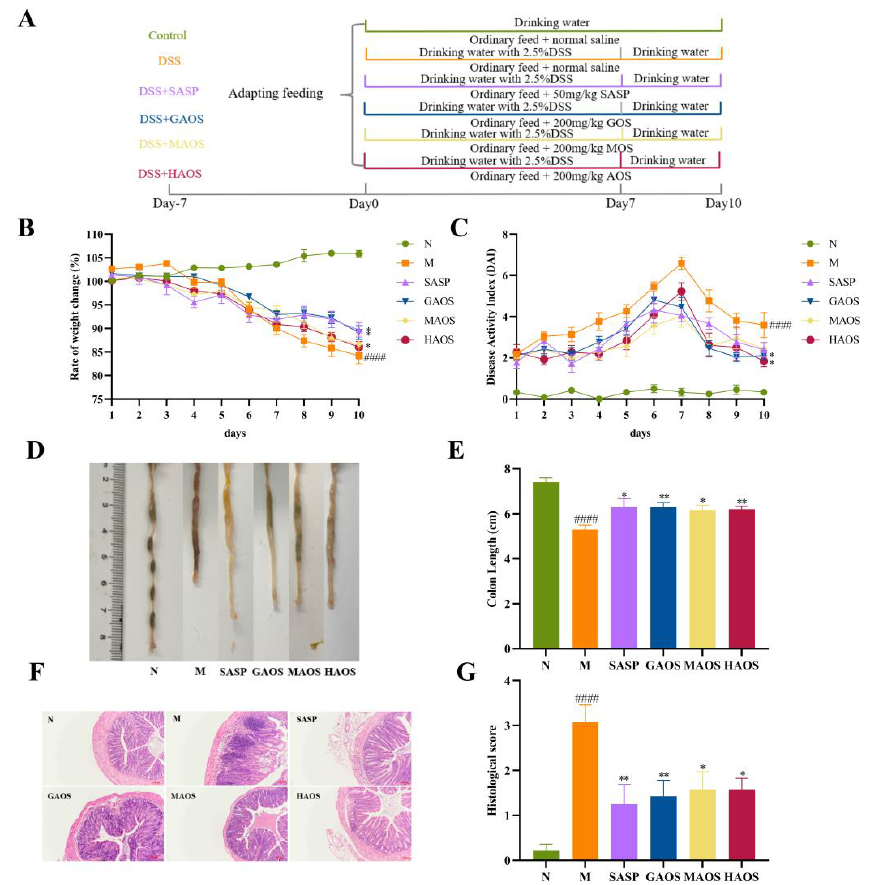
Figure 1. Effect of alginate oligosaccharides supplementation on histopathology of DSS-induced colitis. ( A ) Experimental design. ( B ) Rate of weight change (%). ( C ) Disease activity index (DAI). ( D ) Representative images of the colon from N, DSS, SASP, GAOS, MAOS, and HAOS groups. ( E ) Colon length of mice (cm). ( F ) Hematoxylin and eosin (HE) staining of colon tissues (magnification × 400). ( G ) Histological scores. Data were mean ± SEM ( n = 8). #### p < 0.0001 vs. the N group; * p < 0.05, ** p < 0.01, vs. the M group.